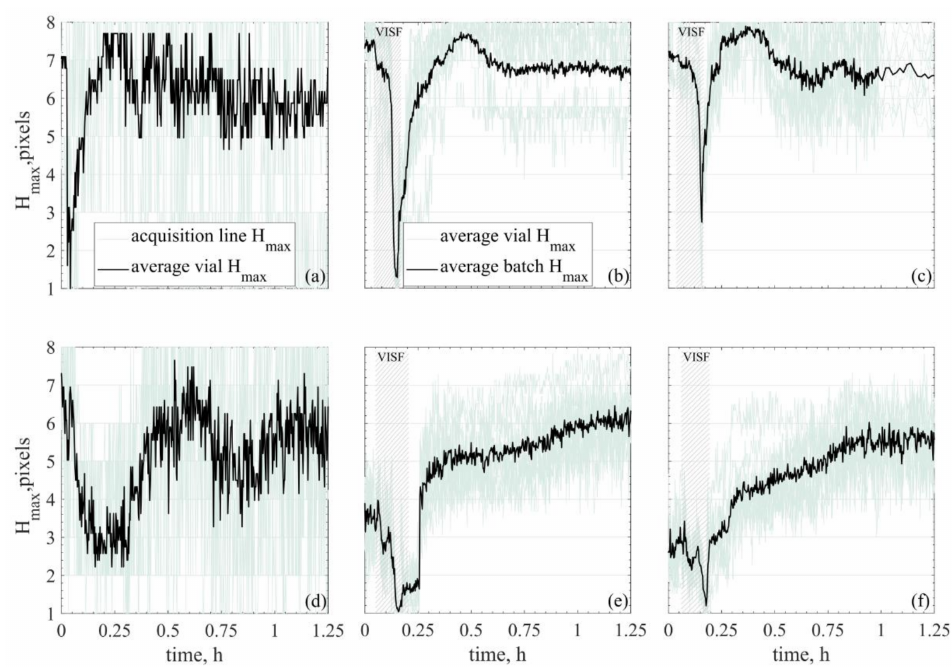
Figure 5. T max axial position ( H max ) during the freezing interval of 5% sucrose. Top graphs ( a – c ) are ON-shelf, while bottom graphs ( d – f ) are OFF-shelf. For the spontaneous nucleation ( a , d ), H max is the average profile obtained from the six acquisition lines of a single vial (shadows plotted in light green). For VISF ( b , c , e,f ), H max is the batch average calculated from the average vial profiles of all ten vials (shadows plotted in light green). Graphs ( b , e ) are VISF at 271 K, ( c , f ) VISF at 263 K.